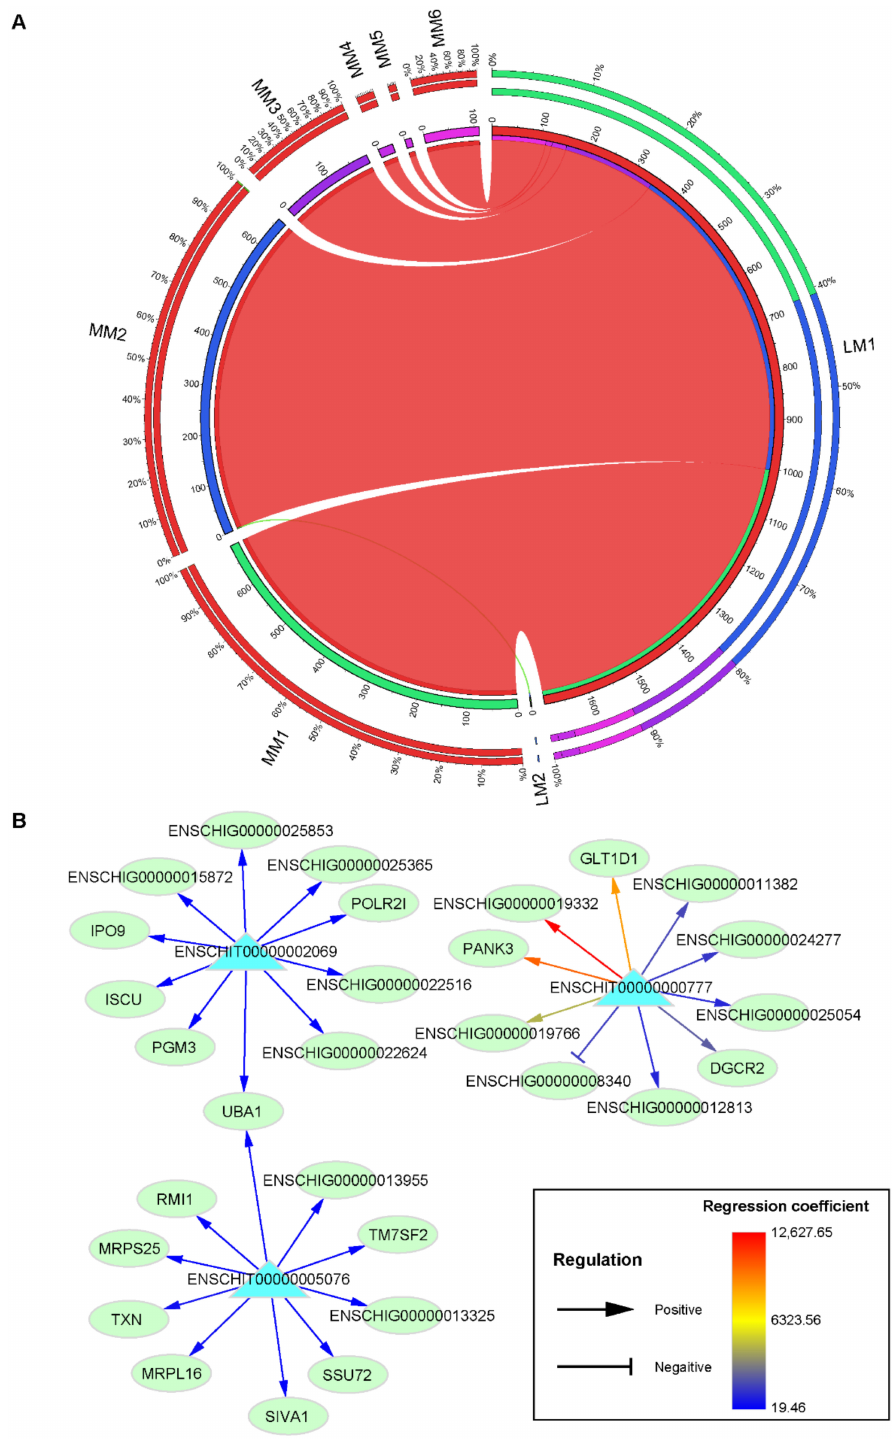
Figure 5. The prediction of the regulatory relationship between lincRNAs and mRNAs. ( A ) Circular presentation of the positive association between lincRNA and mRNA modules. The length of the inside cambered bar represents the number of lincRNAs and mRNAs. The outer cambered bar represents the proportion of lincRNAs and mRNAs with potential regulatory relationships to the number of total lincRNAs (LM modules) and mRNAs (MM modules) in the module to which they belonged. ( B ) The predicted regulatory relationship between hub lincRNAs of module LM1 (blue triangles) and mRNAs (green ellipses). The absolute regression coefficients were ranked and the top ten mRNAs with higher regression coefficients were selected for illustration. The arrow indicates the positive regulatory relationships and the T-shaped head indicates the negative regulatory